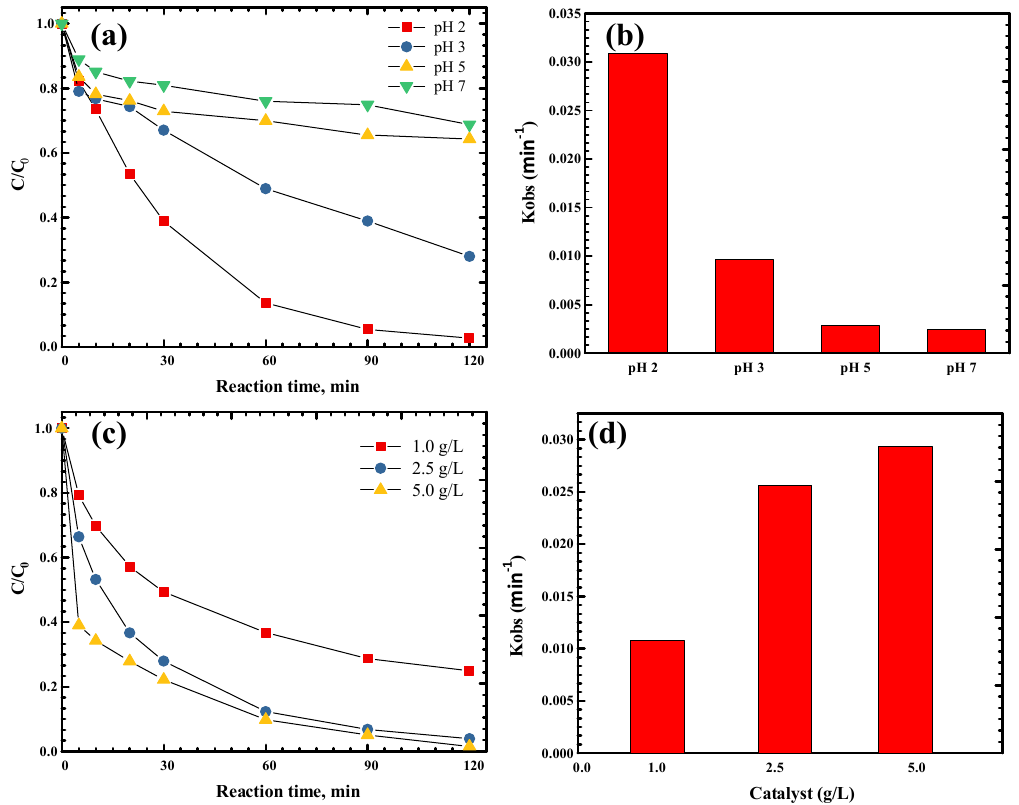
Figure 5. Effects of pH ( a , b ) and mass ratios of Fe ‐ SCG catalyst ( c , d ) on catalytic reduction of TC.